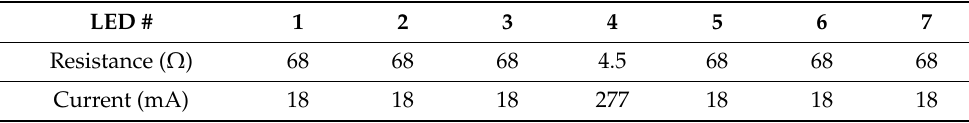
Figure 8. Assembled calibrator with UV LEDs on. Table 3. Constant current conditions for each UV LED in the calibrator